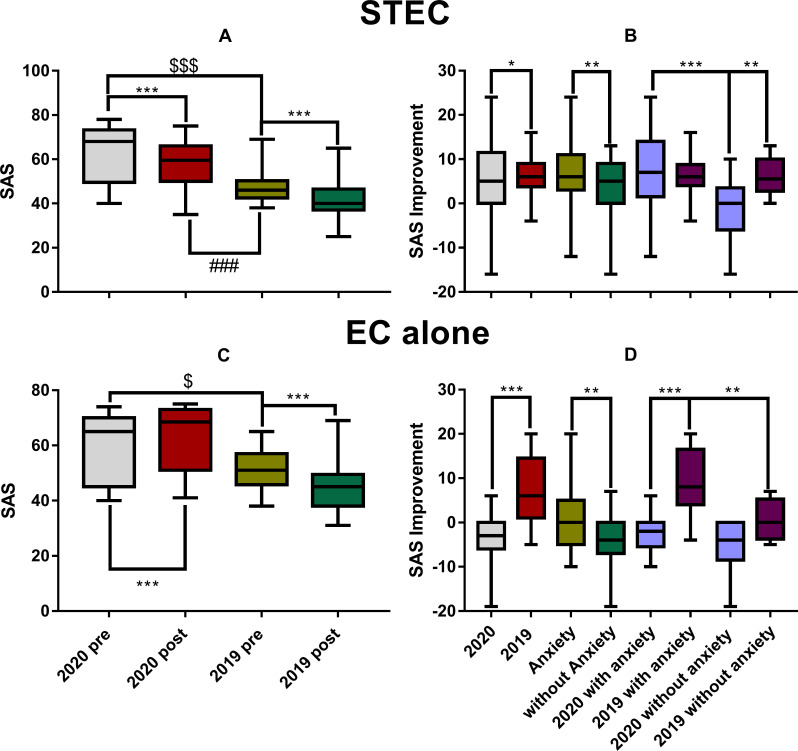
The SAS difference before and after the treatment of STEC (upper panels) and EC alone (the lower panels). A and C: The pre- and post-SAS. B and D: the pre-post difference of SAS score. STEC treatment reduced SAS in both years (A). However, EC alone did not improve SAS in 2020, instead the SAS was increased significantly in the 2nd assessment (C). Correspondingly, STEC produced a slightly better improvement in SAS in 2019 than in 2020, but improvement by EC alone was much better in 2019 than in 2020, in which SAS was deteriorated. The number of symbols (*, $ or #) represents the level of significance, with 1, 2 or 3 symbols for ρ < 0.05, 0.01, or 0.001 respectively. STEC: sound therapy + educational counseling, EC: educational counseling.